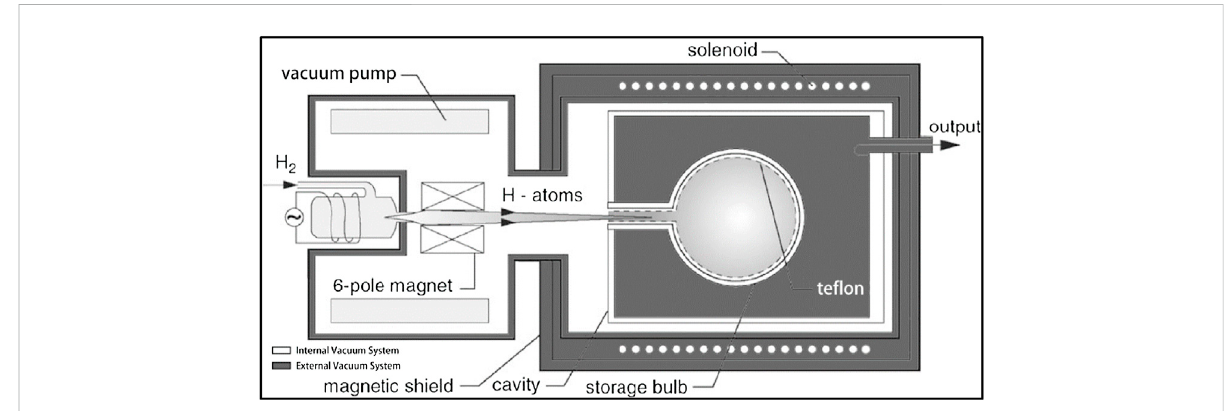
FIGURE 2 Basic structure of the physical part of the hydrogen maser.